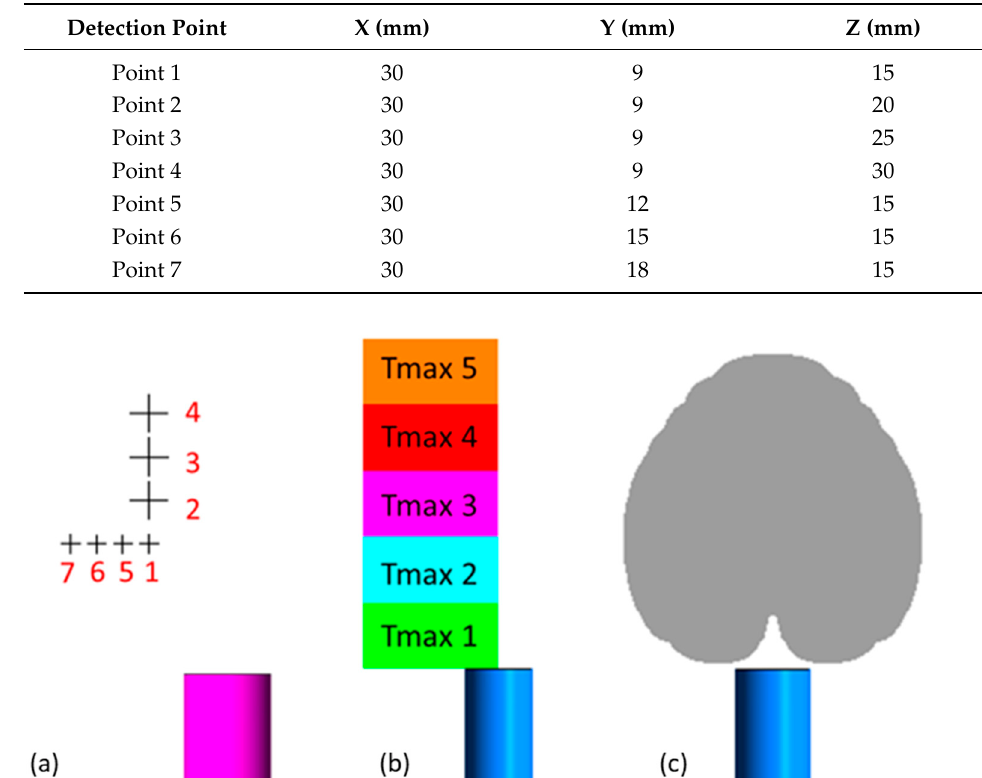
Figure 7. Temperature contours in a cross-section as a function of vf. Table 1. Point probe coordinates.